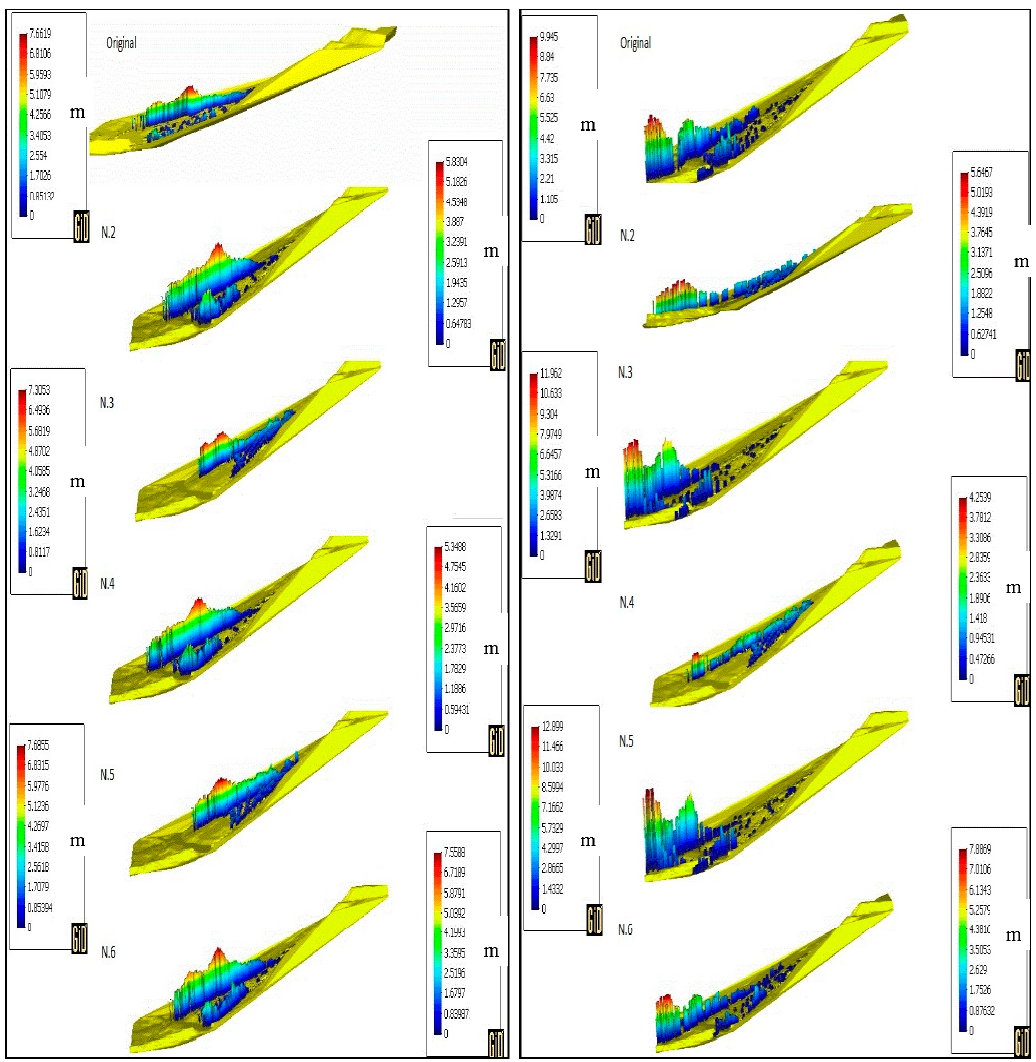
Figure 13. Height profile of the sliding mass at 30 s ( left ) and 50 s ( right ) for the simulations with the parameters in Table 3.